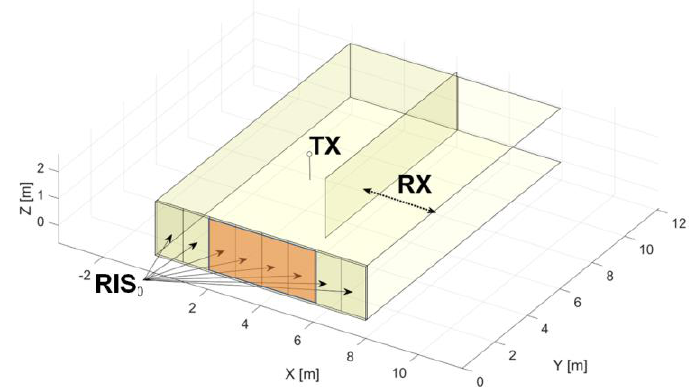
Figure 10. Representation of the simulation scenario with a row of eight anomalous reflectors on the bottom wall or a single focusing RIS (in orange).